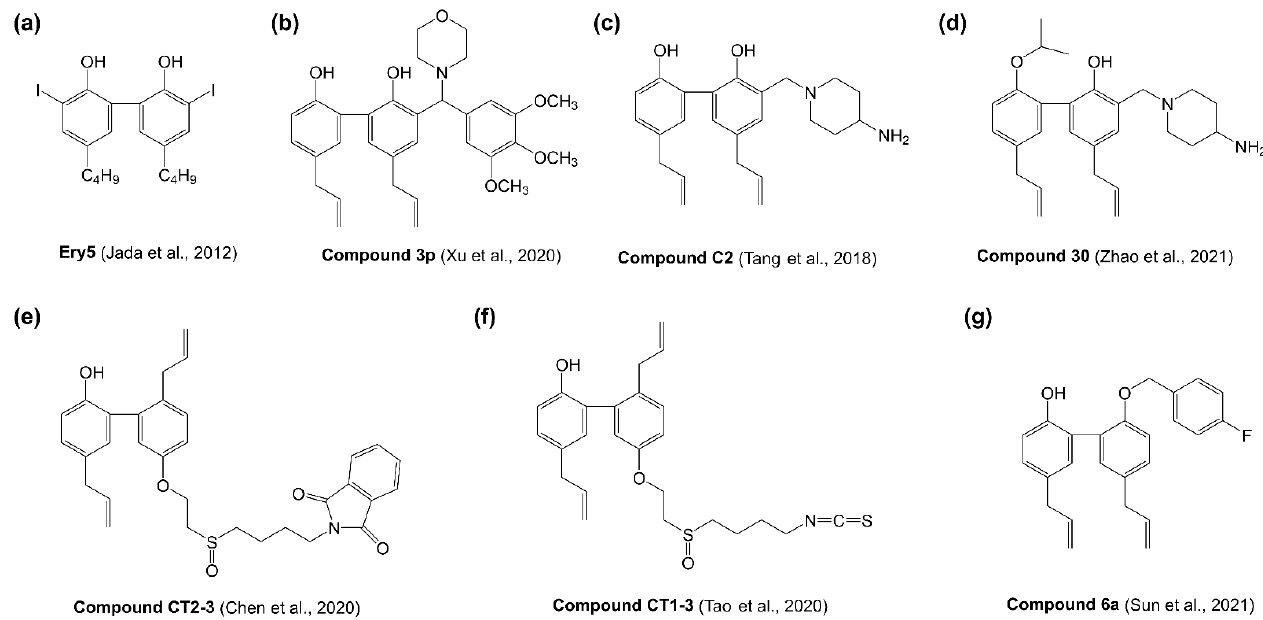
Figure 3. The structure of magnolol synthetic analogues. ( a ) 5,5 ’ -dibutyl-3,3 ’